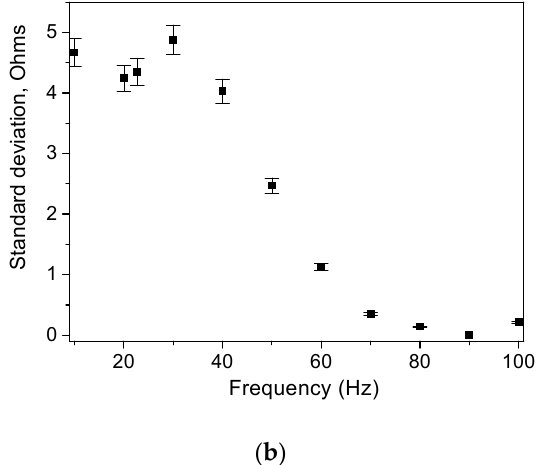
Figure 6. ( a ) Modelled characteristics of the module and the phase of the complex resistance for the equivalent circuit from Figure 2 for the case of KNbO 3 thinner film based piezoelectric transducer; ( b ) standard deviation between experimental and modelled curves.